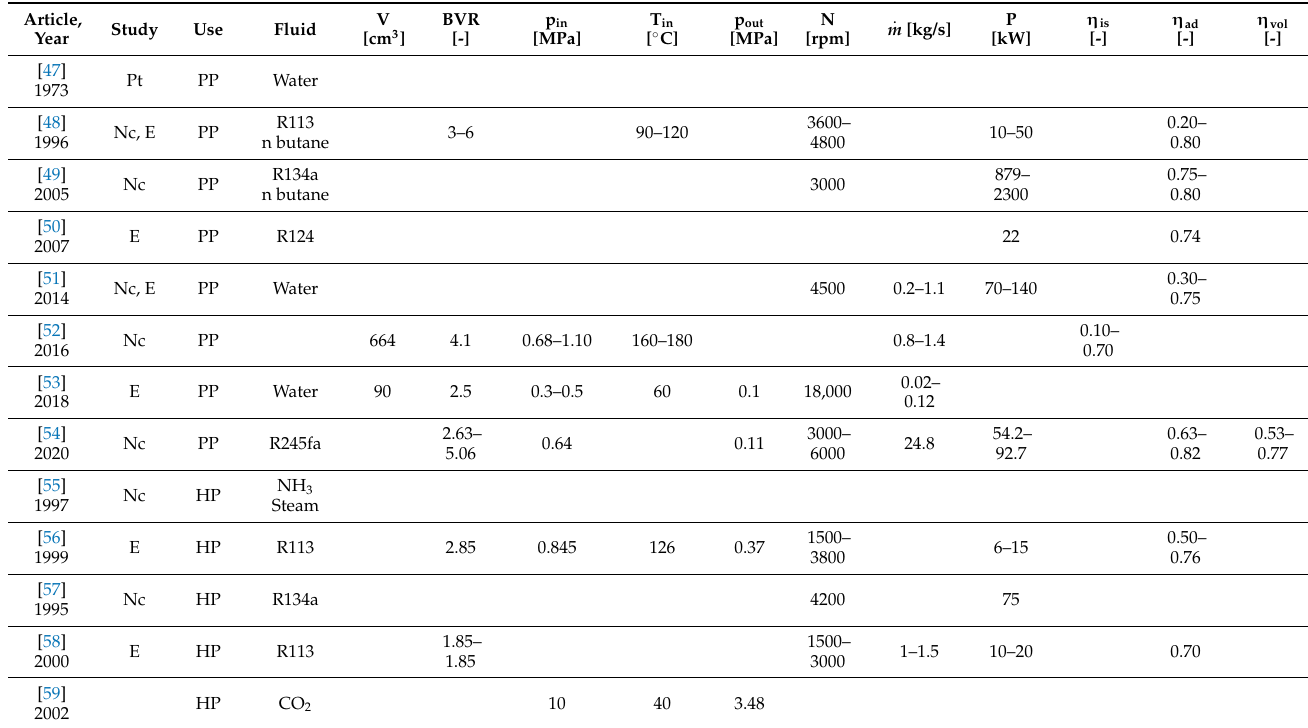
Table 2. Experimental and numerical results related to two-phase screw